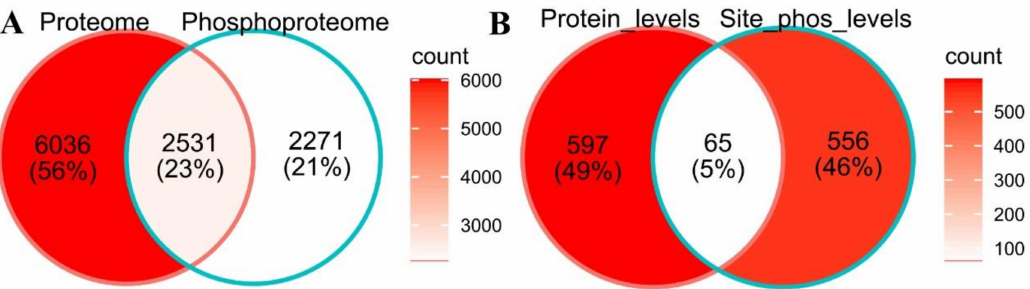
Figure 7. Venn diagrams showing the overlap between proteins observed in the proteome and in the phosphoproteome analyses ( A ), and between cold-responsive proteins at protein abundance levels and at site-specific phosphorylation levels ( B ) in maize seedlings during cold